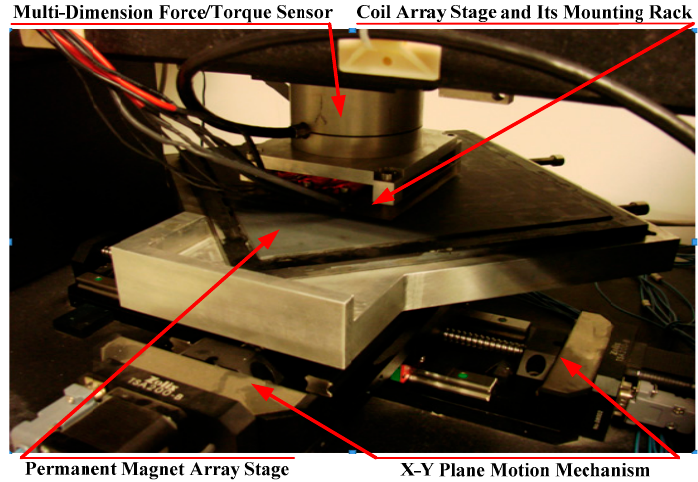
Figure 11. Photograph of comprehensive measurement platform (system).